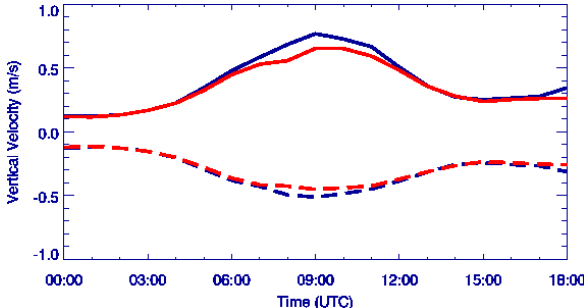
Fig. 14. Averaged column maximum vertical velocity. The solid lines represent the updraft and the dashed lines represent the down- draft. The dark blue lines represent the P-case and the red lines represent the